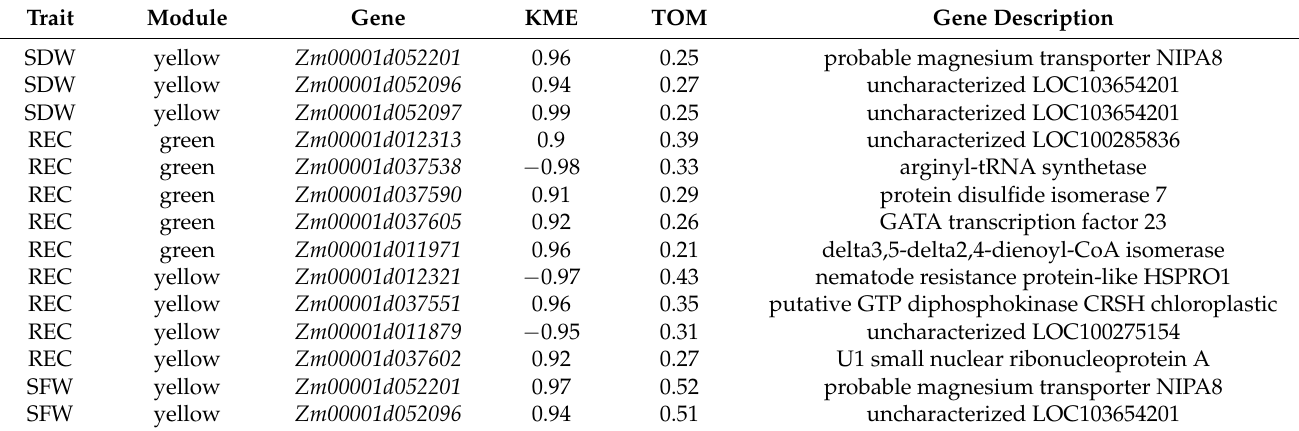
Table 3. Details of hub genes detected by